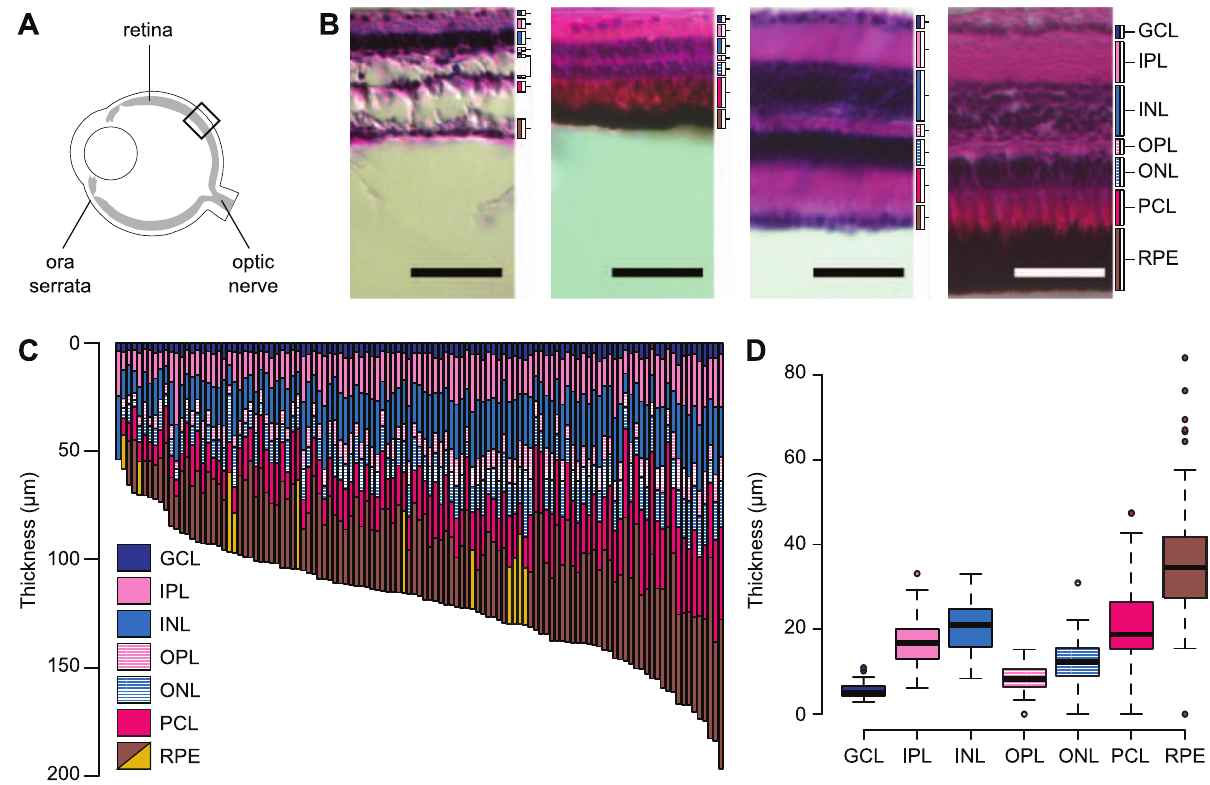
Figure 1. Variation in retinal thickness among Astyanax F 2 hybrids. (A) Diagram of the eye, retina, and retinal landmarks. Black box indicates an example region where we recorded retinal thickness. (B) Example retinal sections from the eyes of four F 2 hybrids. Scale bar denotes 50 m m and brackets denote individual retinal layers. Cavefish-like retinas (first two panels) were generally thin and may be missing some layers entirely, including the photoreceptor cell layer. Surface fish-like retinas (last two panels) were generally thicker with layers that are well-differentiated and clearly laminated. In some individuals, the retinal pigment epithelium (RPE) was hypopigmented (first and third panels). (C) Retinal thickness among 115 Astyanax SFxCF F 2 hybrids. Yellow bars denote RPEs that were hypopigmented. (D) Box-plots illustrate variance in the thickness of individual retinal layers. The retinal layers shown are: ganglion cell layer (GCL), inner plexiform layer (IPL), inner nuclear layer (INL), outer plexiform layer (OPL), outer nuclear layer (ONL), photoreceptor cell layer (PCL), and retinal pigment epithelium (RPE).